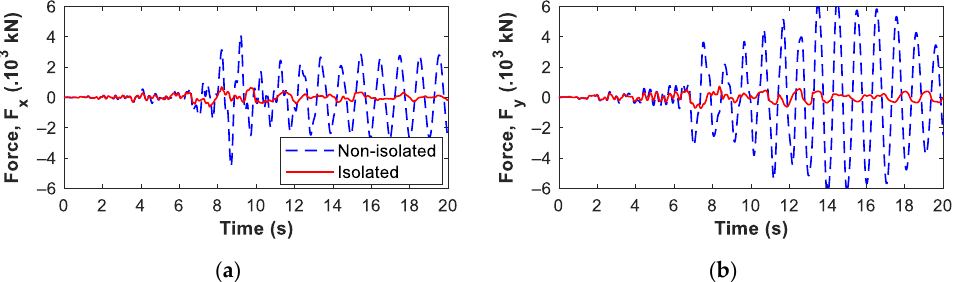
Figure 8. Time history of the 1st-floor shear force of the building subjected to Record 2: ( a ) X-response and ( b ) Y-response. Table 2. Peak seismic response of the